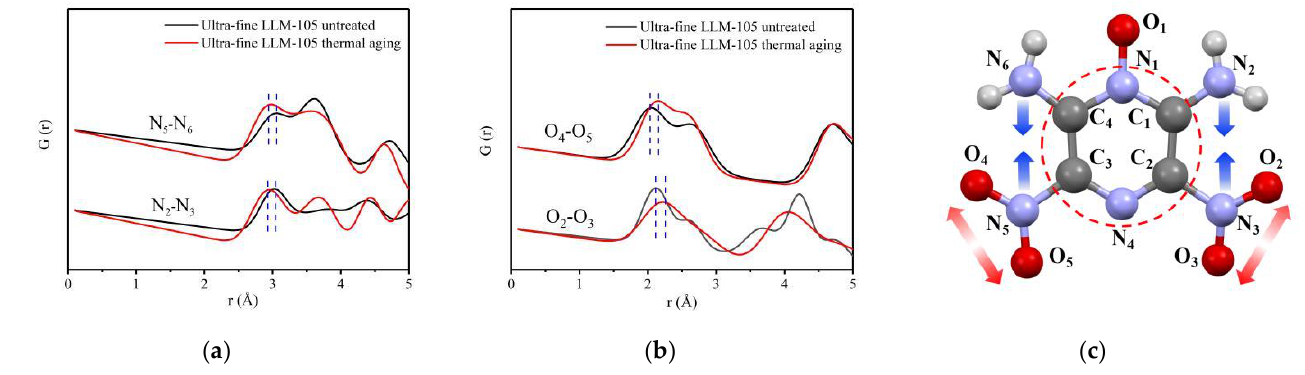
Figure 8. ( a ) PDF curve of N—N atom pair in LLM-105; ( b ) PDF curve of O—O atom pair in LLM-105; ( c ) Schematic diagram of changes of atomic pairs in LLM-105 molecule after thermal aging.